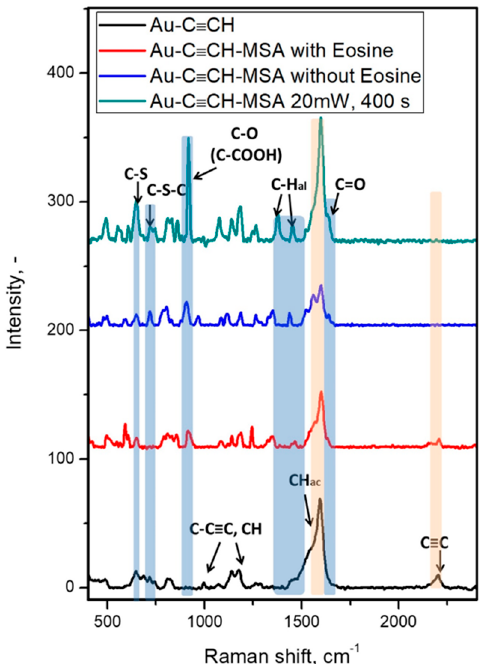
Figure 2. Raman spectra of gold gratings modified by ADT-C ≡ CH, after grafting with mercaptosuccinic acid (MSA).